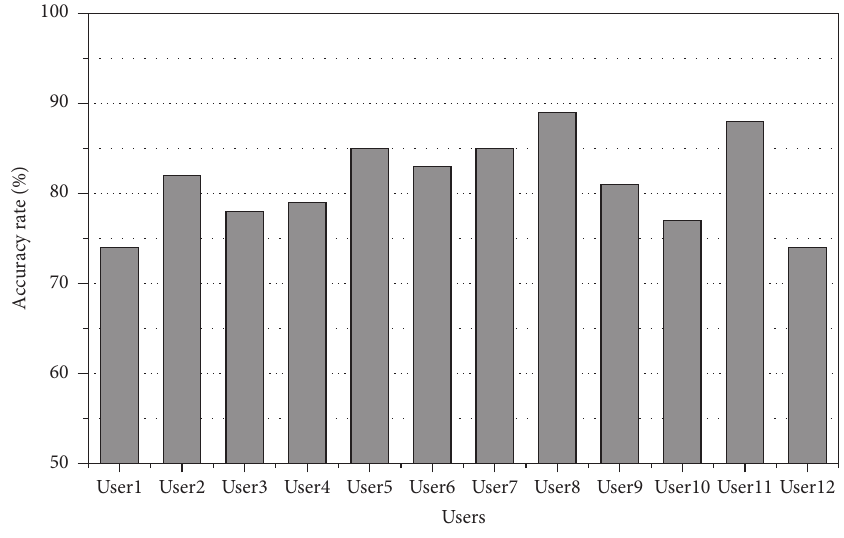
Figure 6: Classification accuracy of Bayesian method model. Table 1: Configuration information of experimental environment.